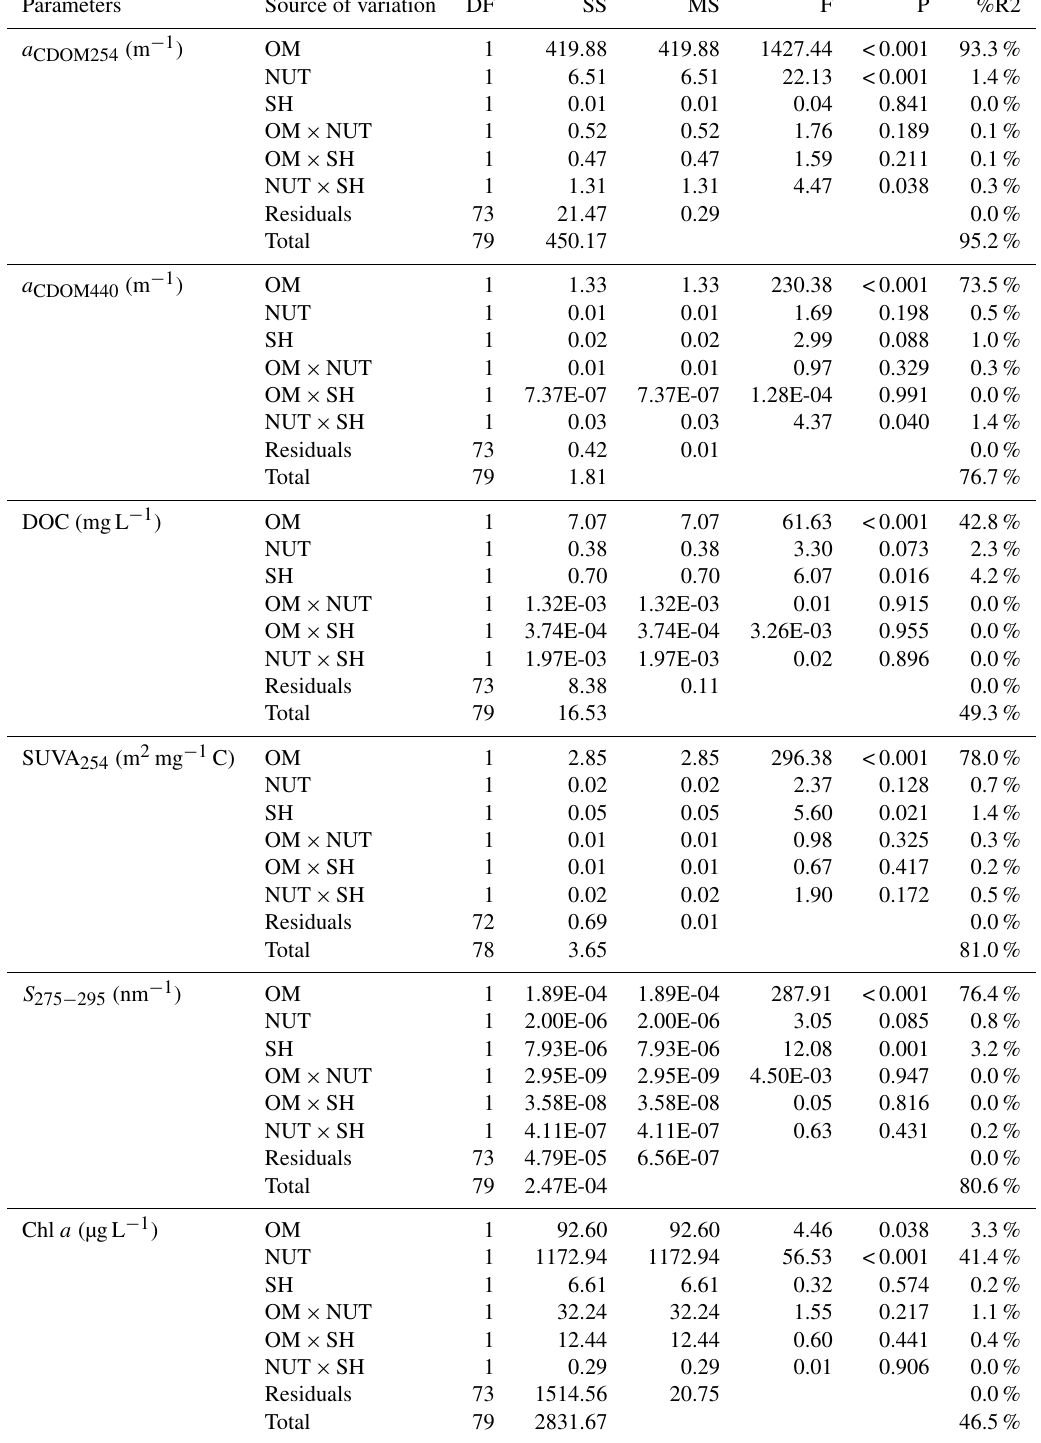
Table 1. Results of the three-way analysis of variance. The coefficient of determination of the analysis of variance partition is represented in the last column by